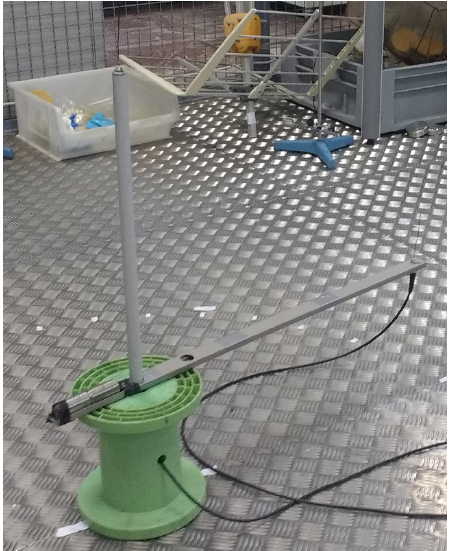
Figure 12. Antenna layout for three dimensional localization.